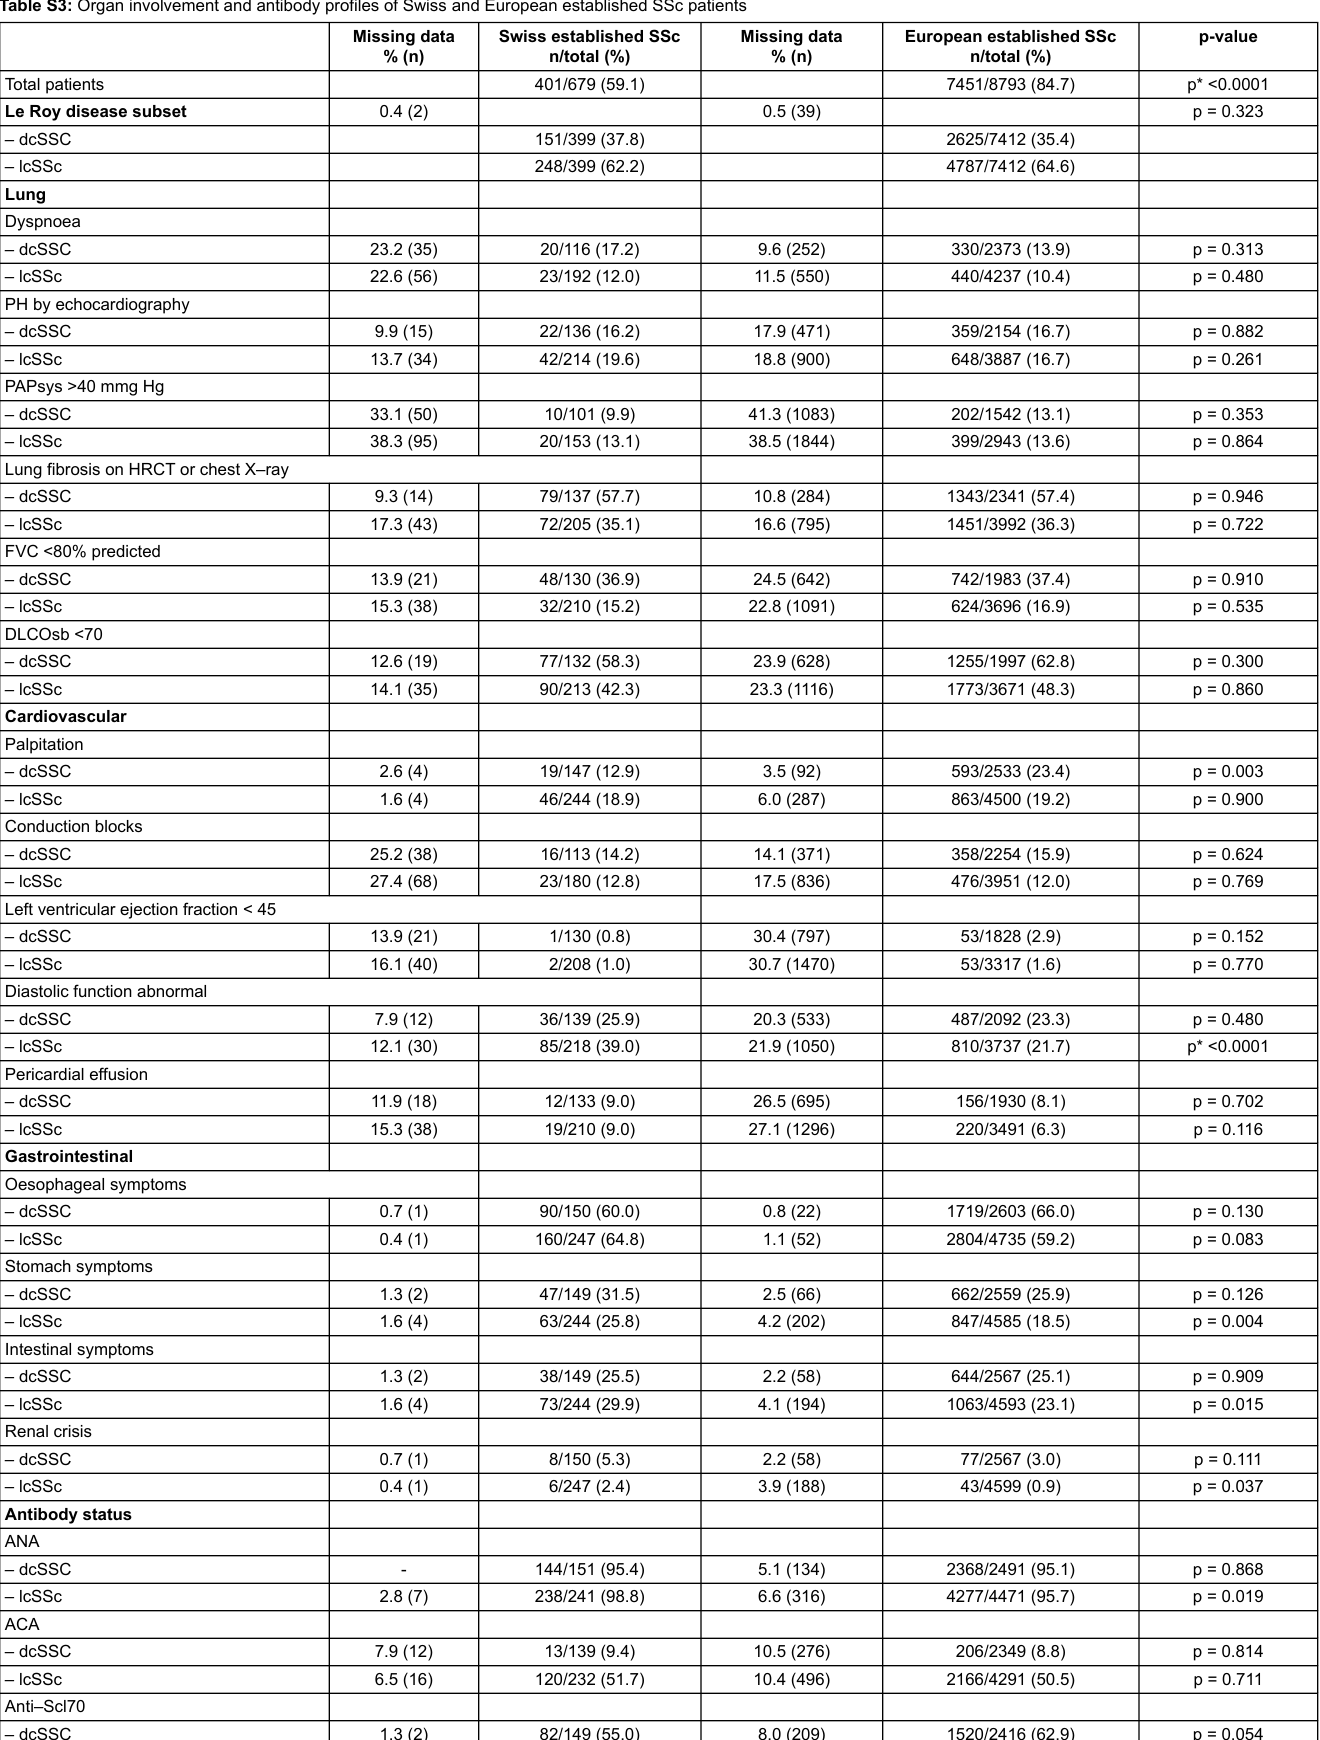
Table S3: Organ involvement and antibody profiles of Swiss and European established SSc